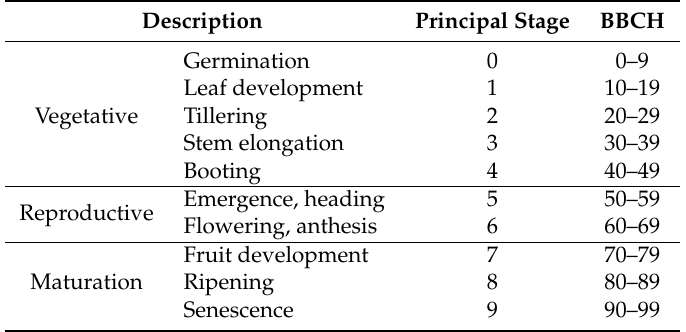
Table 1. Description of the rice phenological cycle according to the BBCH scale